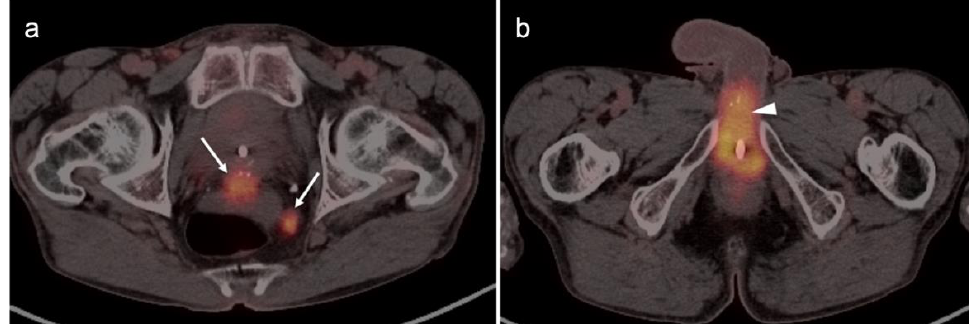
Figure 54. Squamous cell carcinoma of the base of the penis, spread from a cutaneous perineal squamous cell carcinoma. ( a ) Axial FDG PET-CT at left shows intrapelvic tumor deposits (white arrows). ( b ) Hypermetabolic tumor involves the base of the penis (white arrowhead). A Foley catheter is in place.